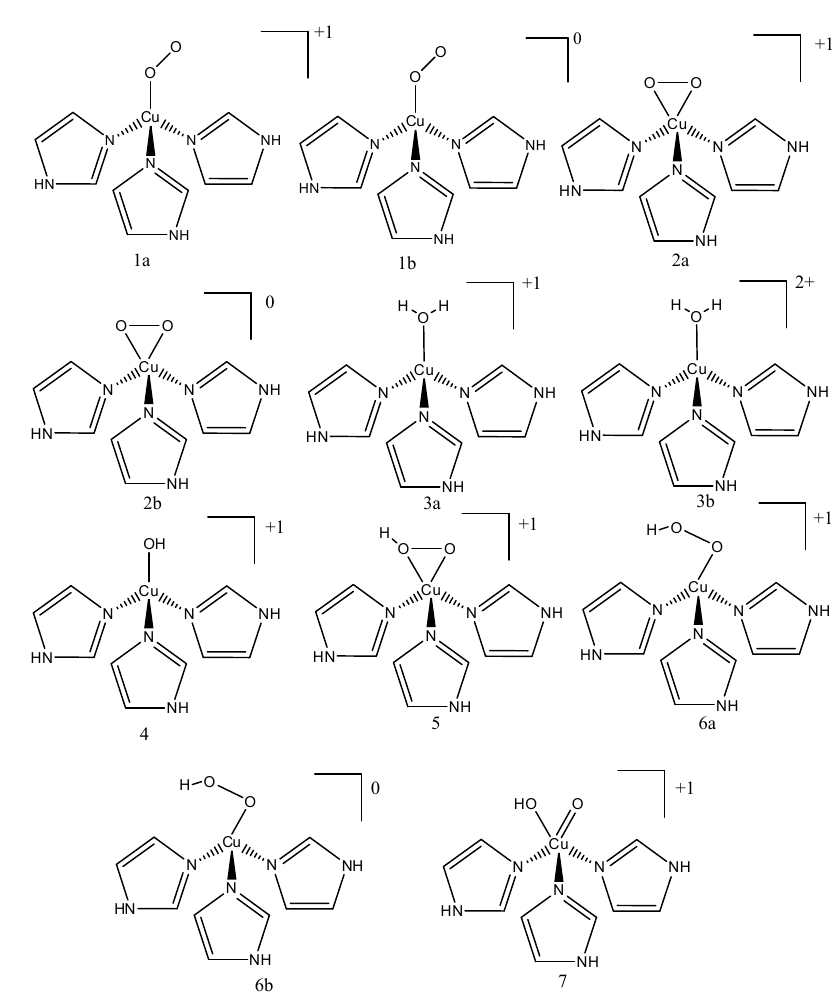
Figure 2. Models employed in the present